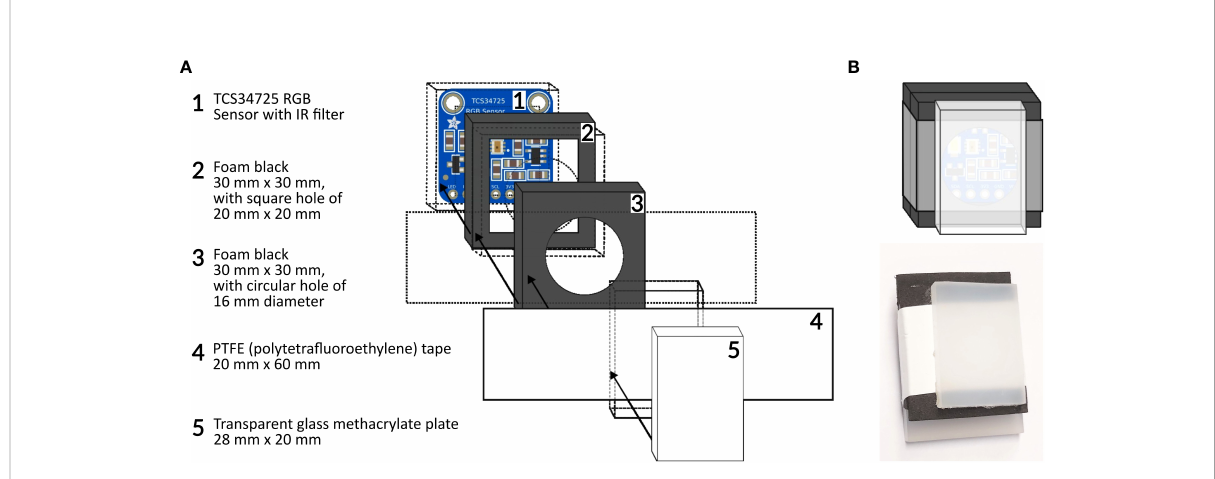
FIGURE 2 (A) Schematic drawing of the corrective cosine fi lter in the KduPRO. (B) Final schematic and image of the corrective cosine fi